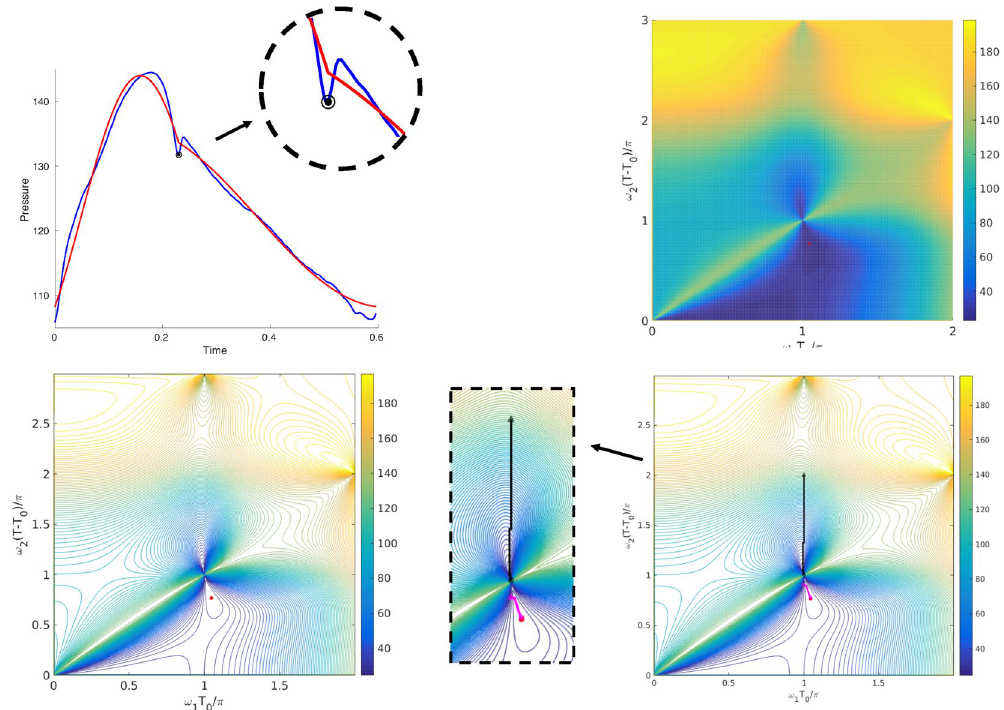
− ( ) ω P , T T T ( ) 1 0 2 0 for the cycle in left with the location of the π π − ( ) ω P , T T T ( ) 1 0 2 0 . The location of the minimizer of P π π − ( ) ω P , T T T ( ) 1 0 2 0 and the location of the minimizer of P π π